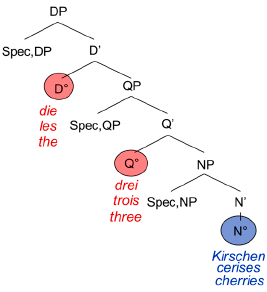
Figure 1. Simplified structure of the DP.